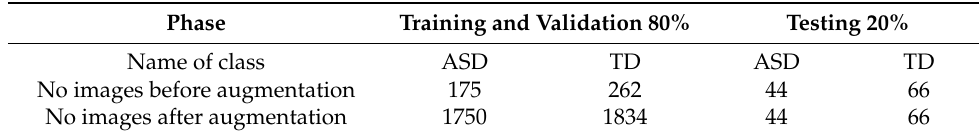
Table 5. Balancing ASD dataset during the training phase.